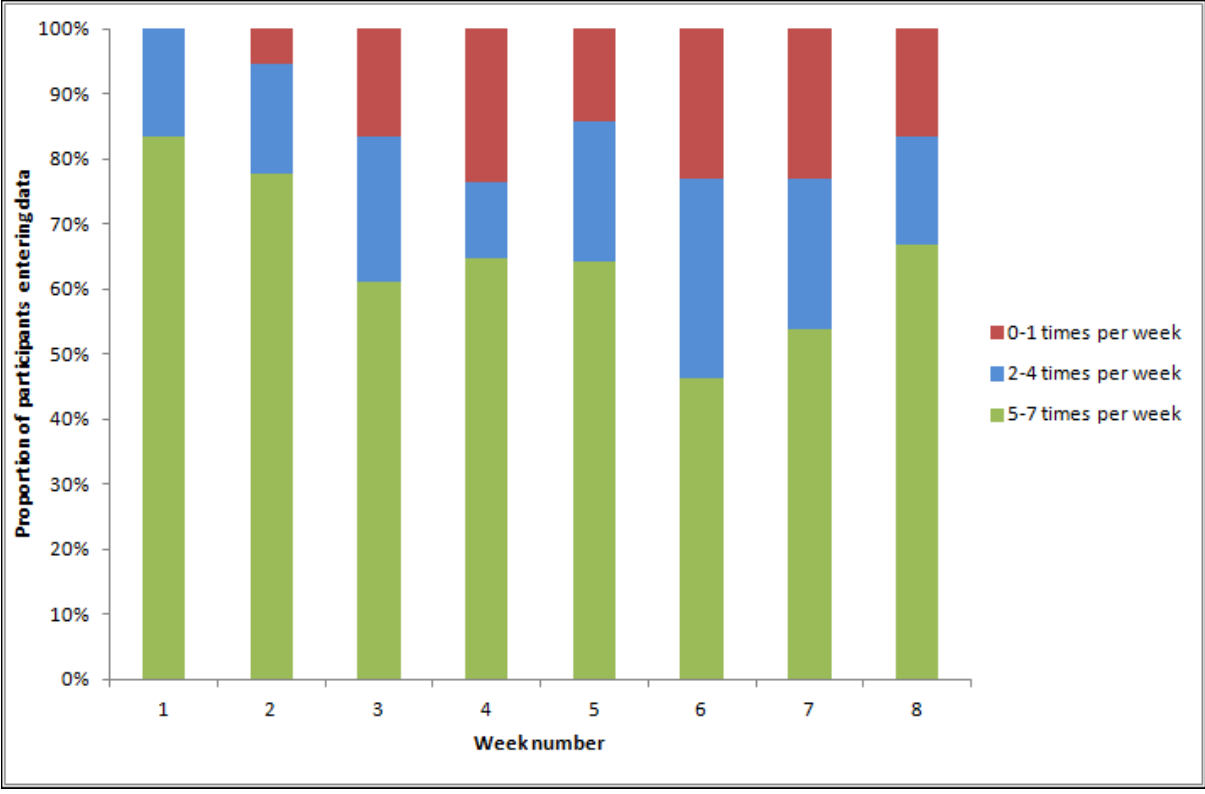
Figure 3. Number of days providing data, by week, for eligible participants.